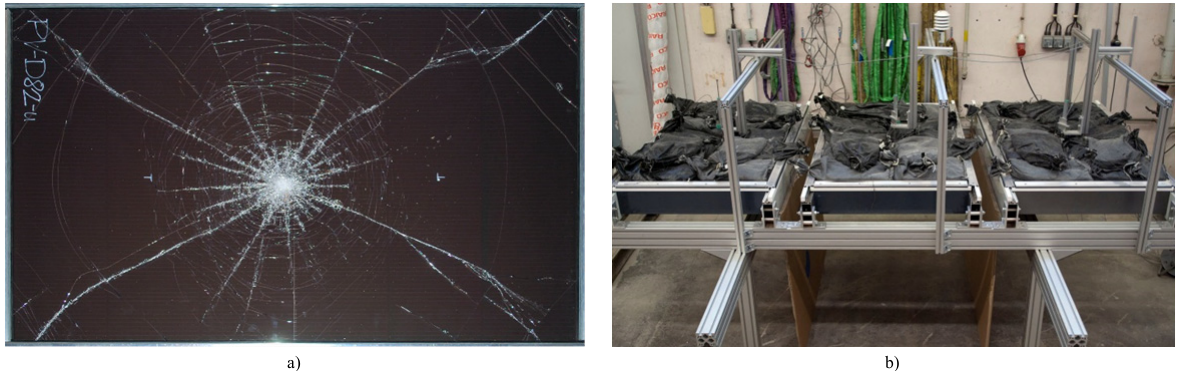
Fig. 11a) Typical fracture pattern of the a-Si/µ-Si superstrate modules (front view) before load application; b) Test rig for the winter scenario at room temperature.